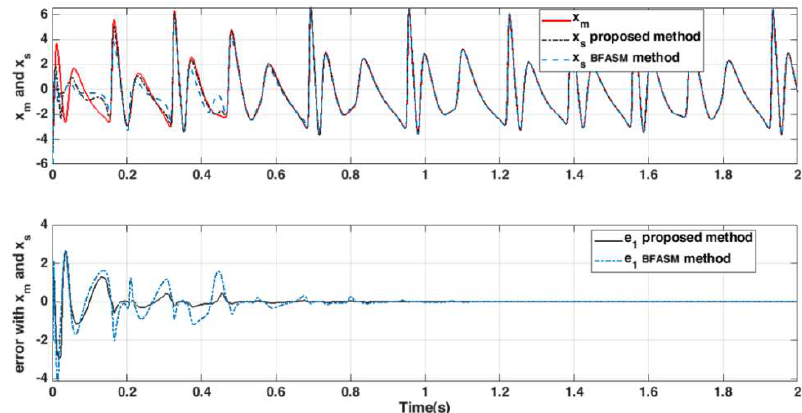
Figure 8. Chaos synchronization and synchronization error of master–slave systems in x m , x s .